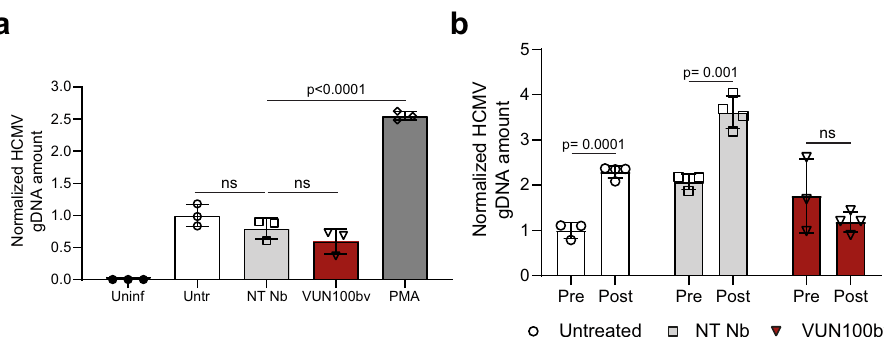
Fig. 5 VUN100bv treatment drives a T-cell-mediated reduction of HCMV reactivation without driving viral DNA replication in latently infected cells. a Quanti fi cation of HCMV gDNA copy numbers of uninfected (Uninf) or HCMV-US2-6 infected CD14 + monocytes before co-culture with CD4/CD8 + T cells. Infected monocytes were untreated (Untr), treated with a non-targeting nanobody (NT Nb), VUN100bv, or 20 ng/ml PMA (PMA) for 6 days. Total genomic DNA was harvested and HCMV gDNA copy numbers were determined by quantifying GAPDH and UL44 gene numbers via qPCR. HCMV gDNA copy numbers were normalized to the untreated infected wells. b Quanti fi cation of HCMV gDNA copy numbers of untreated NT Nb or VUN100bv treated HCMV-US2-6 infected CD14 + monocytes after co-culturing with CD4/CD8 + T cells. HCMV gDNA copy numbers were determined prior to (Pre) and after (Post) differentiation of CD14 + monocytes to mature dendritic cells and co-culturing with fi broblasts for 8 days. Total genomic DNA was harvested and HCMV gDNA copy numbers were determined by quantifying GAPDH and UL44 gene numbers via qPCR. HCMV gDNA copy numbers were normalized to the untreated wells prior to differentiation to mature dendritic cells. Representative fi gures, showing technical replicates, from three biological replicates are shown. All data are plotted as mean ± S.D. For all fi gures, statistical analyses were performed using unpaired two-tailed t test. ns, p > 0.05. Source data are provided as a Source Data fi